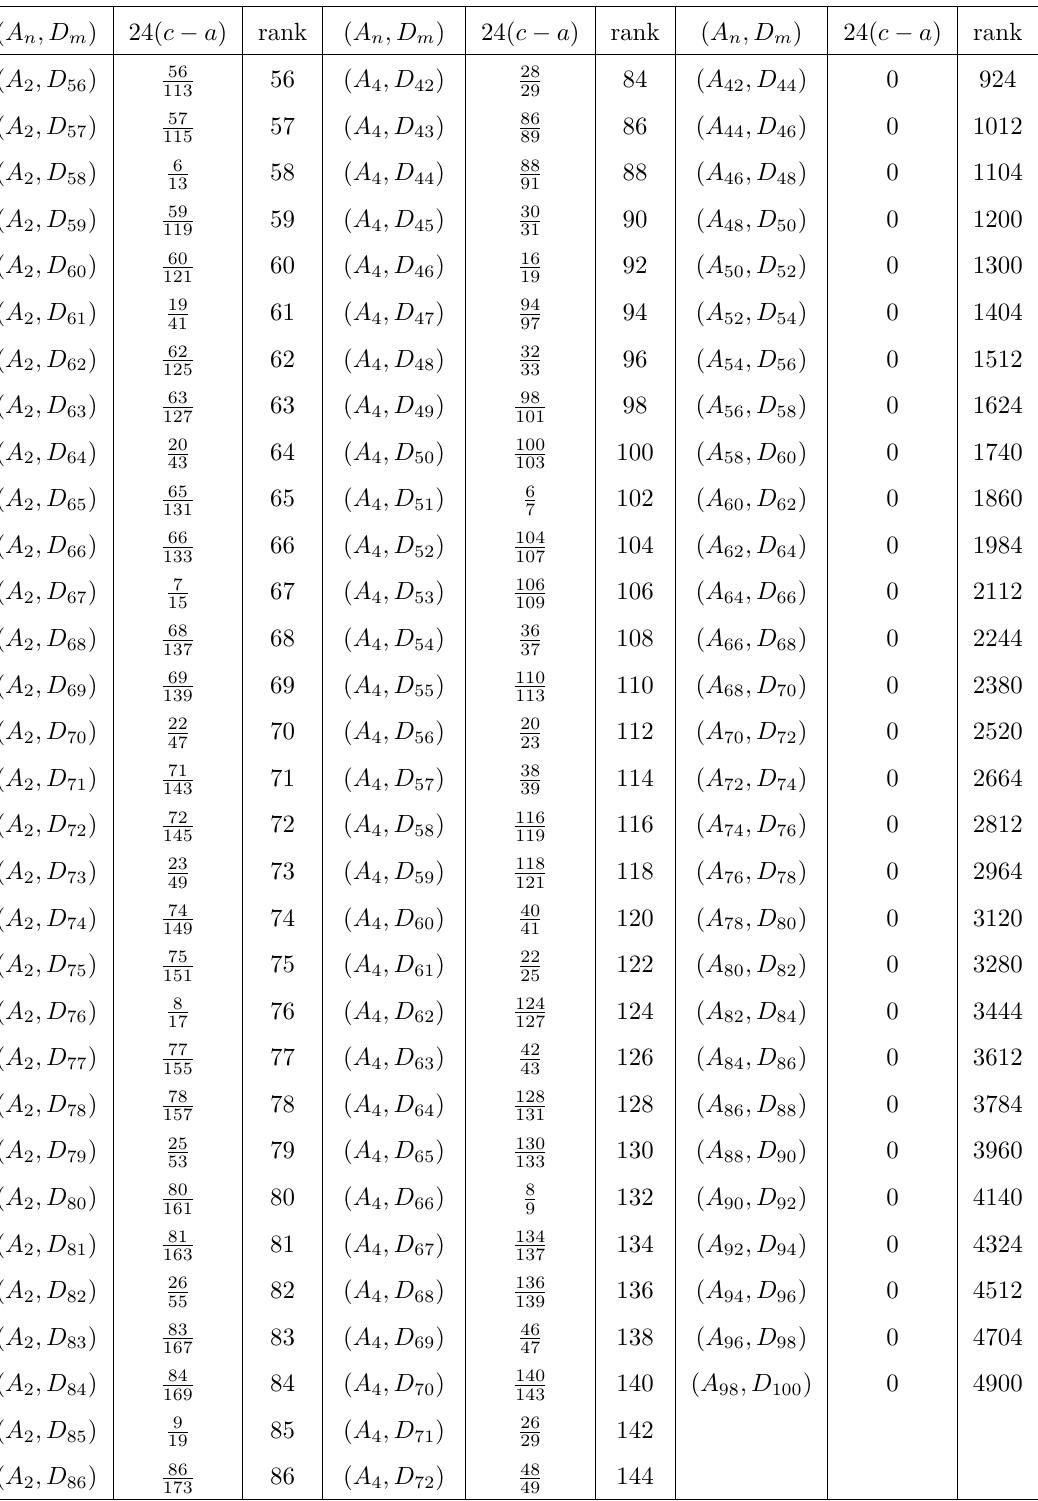
Table 3. ( A n , D m ) with 1 ≤ n, m ≤ 100